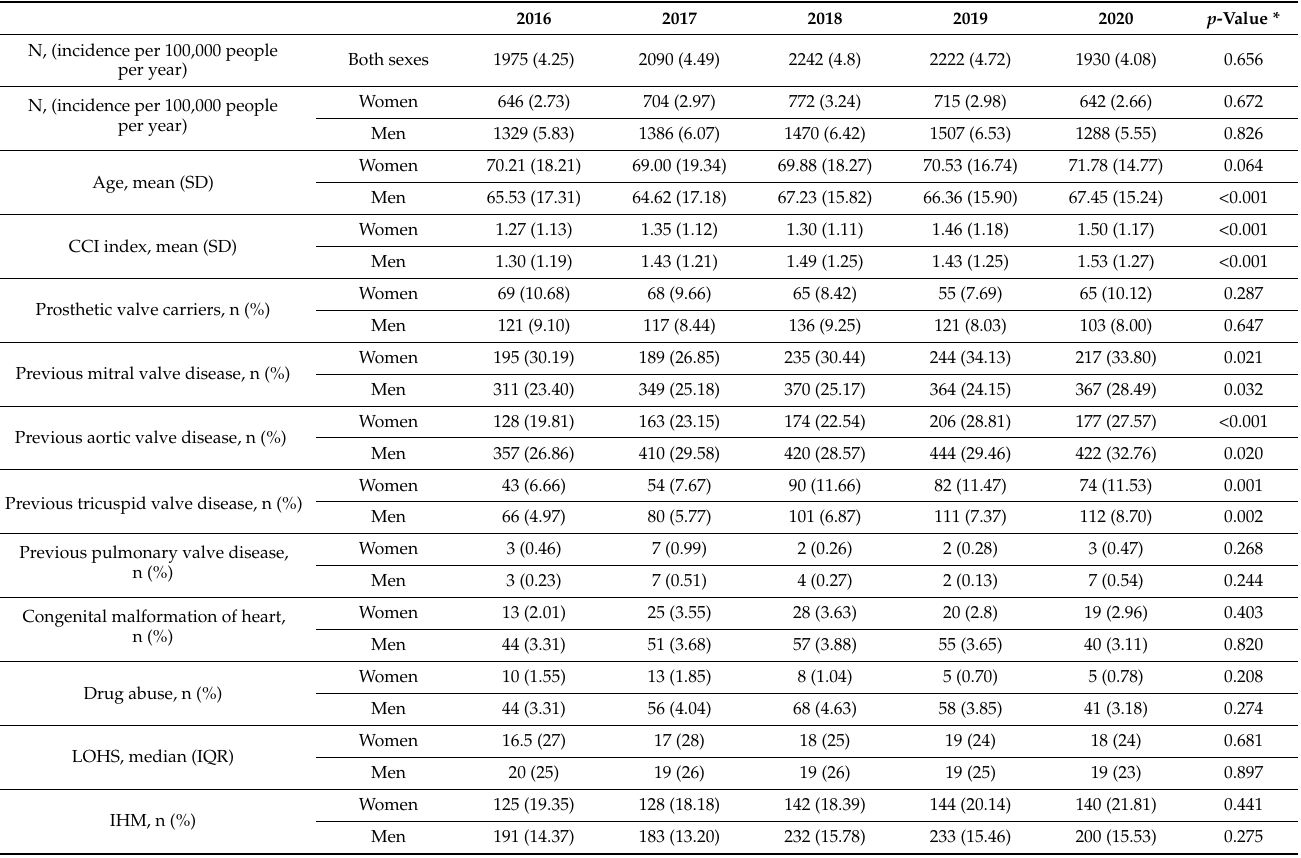
Table 1. Incidence, clinical characteristics, and in-hospital outcomes of patients hospitalized with infective endocarditis in Spain from 2016 to 2020 according to